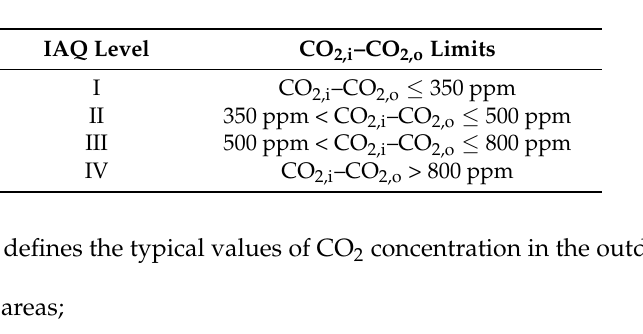
Table 4. Levels of indoor air quality (IAQ) as a function of the indoor–outdoor difference in CO 2